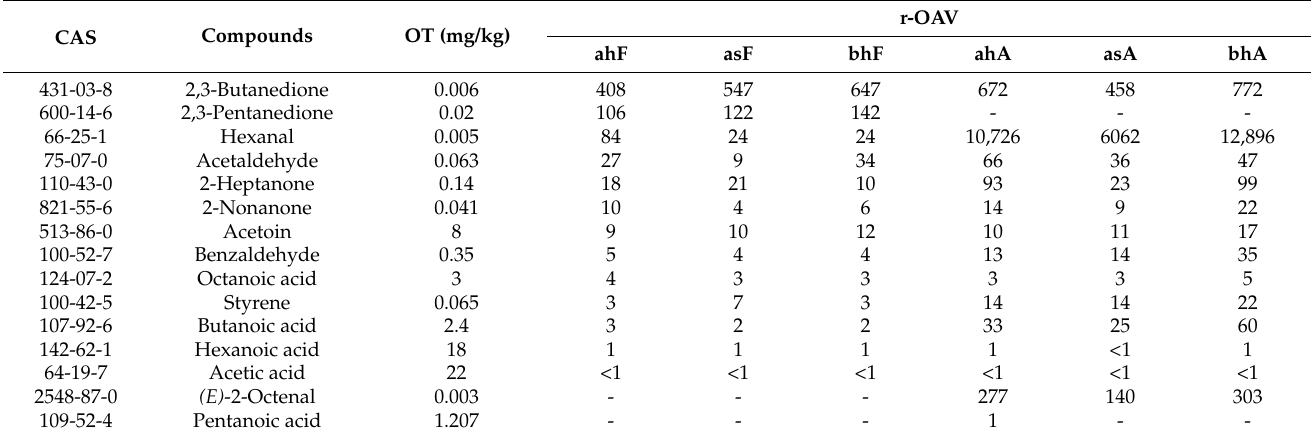
Table 3. Odor thresholds (OT) and relative odor activity values (r-OAV) of odor-active compounds in six pasteurized yogurt